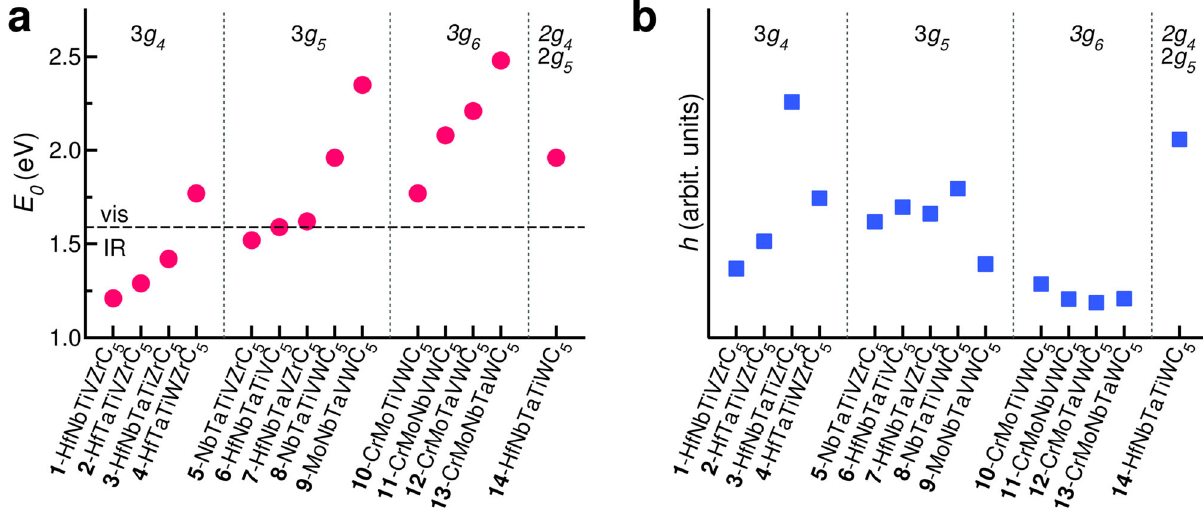
Fig.3|TrendsinthesimulatedPHECs. PropertiesofsimulatedPHECs,orderedin classes according the number of group 4 ( g 4 ), group 5 ( g 5 ), and group 6 ( g 6 ) transition metals included in the compound. Labels are summarized in Table